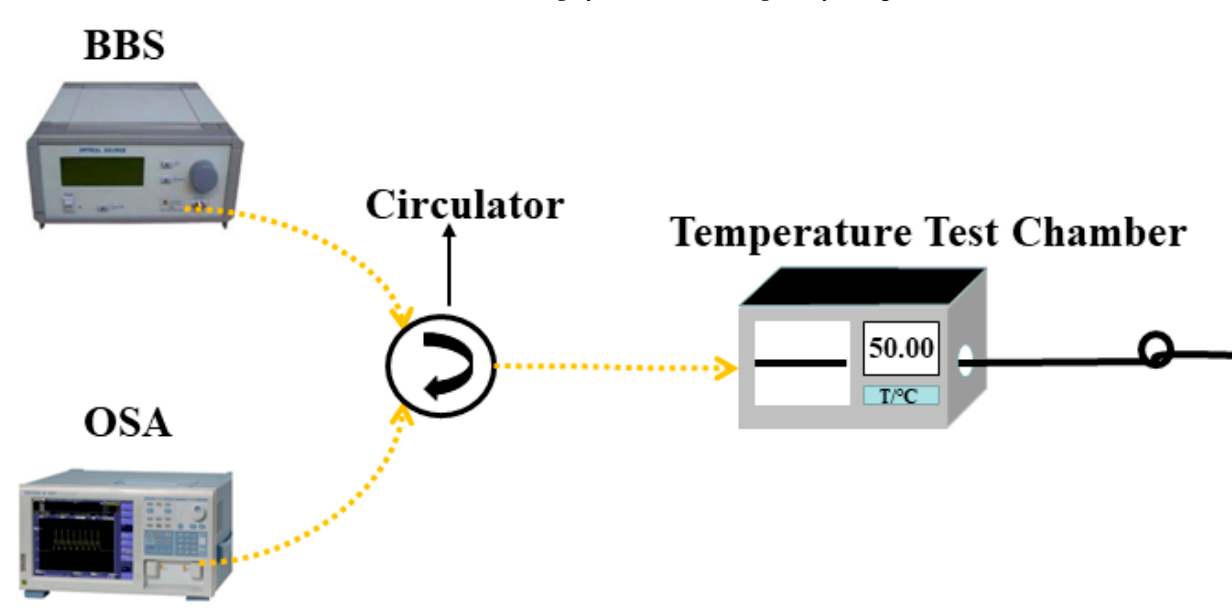
Figure 8. Schematic of temperature experimental setup.